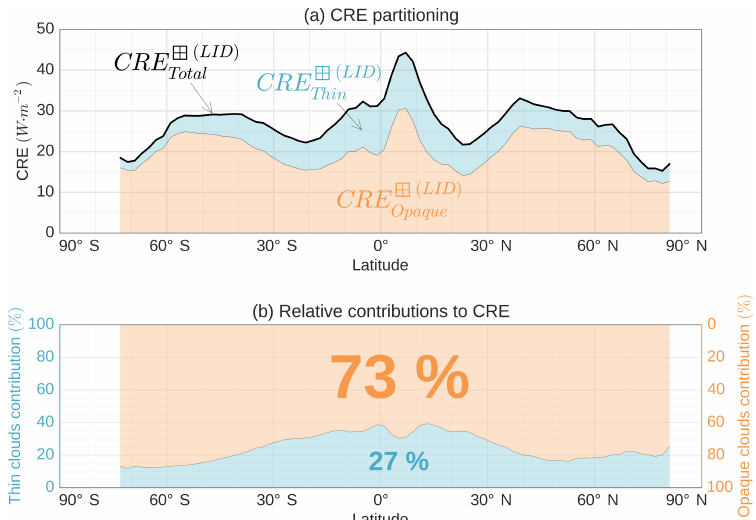
Figure 9. (a) Partitioning of total CRE into opaque CRE and thin CRE. (b) Ratios of the opaque and thin CRE to the total CRE. Only nighttime conditions over ice-free oceans for the 2008–2015 period are considered.